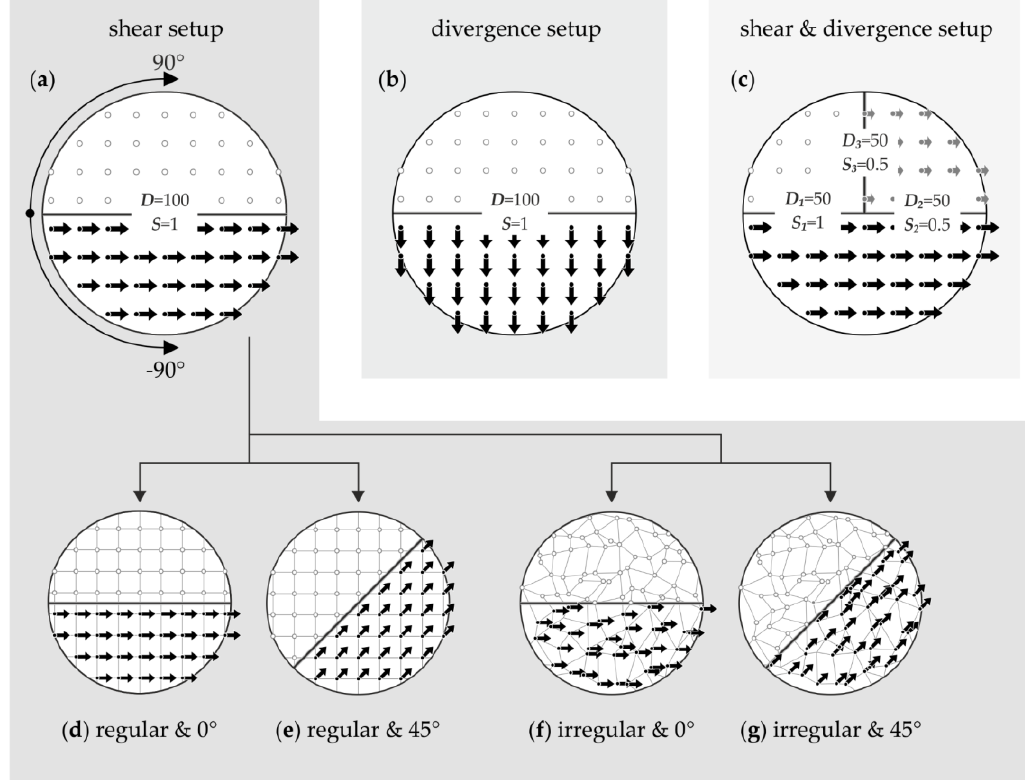
Figure 3. Test setups for the numerical experiments. ( a ) Shear setup, ( b ) divergence setup, and ( c ) shear and divergence setup with the various regions separated by the deformation feature (black line). At the bottom: The two vector distributions, regular ( d ) and irregular ( f ), and examples for rotation (( e , g )). D is the length of the discontinuity segment and S is the sliding distance (relative displacement) along the corresponding discontinuity segment.